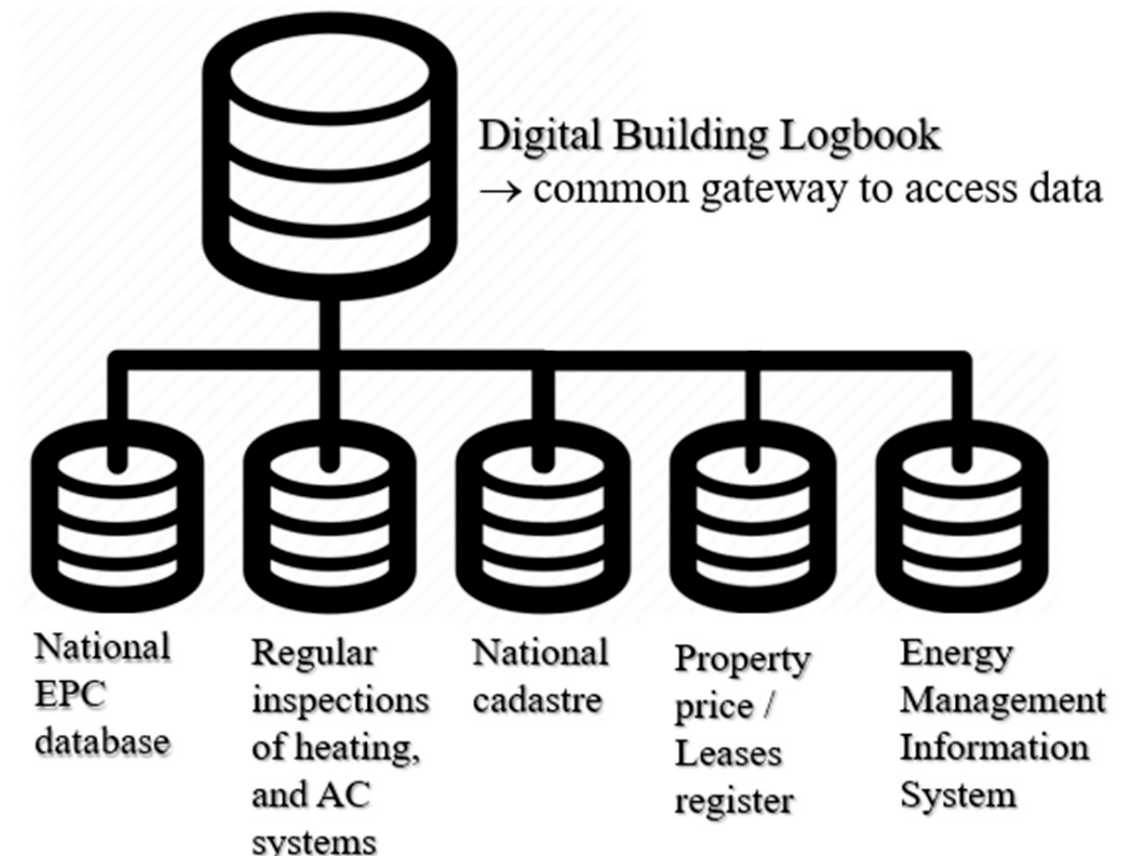
Figure 1. Linkage between digital building logbook and existing national databases.